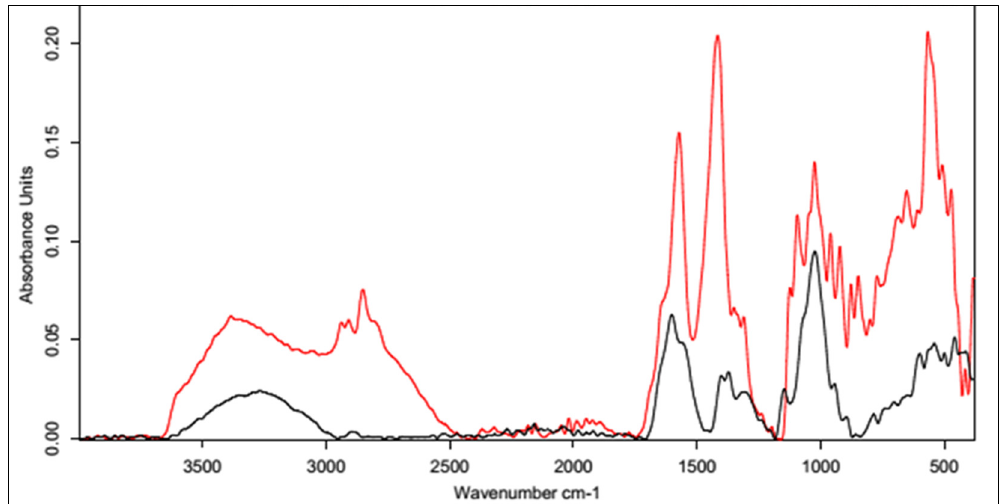
Figure 10. FT-IR spectrum of native HA (black) vs. HA cross-linked with 1,4-butanediol diglycidyl ether, BDDE (red).